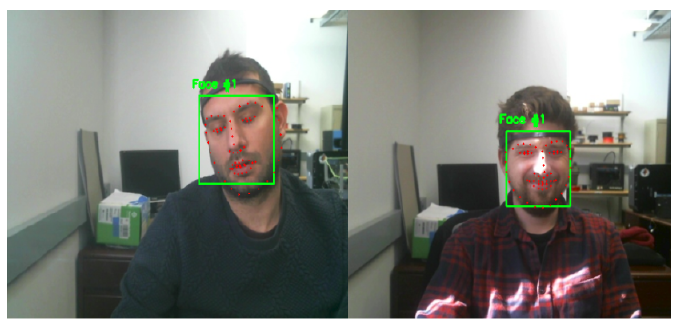
Figure 4. Facial keypoint detection and tracking based on